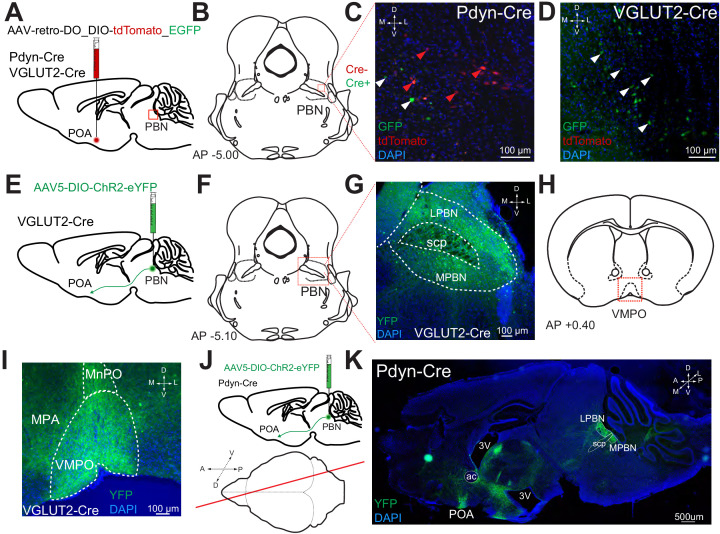
POA-projecting parabrachial nucleus (PBN) neurons are VGLUT2+ and a subpopulation is Pdyn+.(A) Illustration of injections of a retrograde recombinase dependent red-to-green (tdTomato to EGFP) color changing virus (AAV-retro-DO_DIO-tdTomato_EGFP) into the POA of Pdyn-Cre or VGLUT2-Cre mice. (B) Anatomical location of representative brain sections displayed in panels (C) (Pdyn-Cre) and (D) (VGLUT2-Cre). Sections were analyzed for GFP and/or tdTomato expression in LPBN. Cre- neurons transduced by the virus express tdTomato (red), Cre+ neurons express EGFP. (C) In brain sections taken from Pdyn-Cre mice, neurons expressing tdTomato (Cre-, red) and EGFP (Cre+, green) are observed. White arrowheads mark EGFP expressing Cre+ cells; red arrowheads mark tdTomato expressing Cre- cells (n = 3 animals). (D) In brain sections taken from VGLUT2-Cre mice, only Cre+ cells expressing EGFP are observed (white arrowheads). (E) Illustration of viral injections into PBN of VGLUT2-Cre mice to label VGLUT2PBN→POA projections. (F) Anatomical location of representative brain sections displayed in panel G. (G) Expression of eYFP in medial and lateral PBN of VGLUT2+ mice after injection of AAV5-DIO-ChR2eYFP into the PBN. (H) Anatomical location of representative brain sections displayed in panel (I) showing the POA projections of PBN VGLUT2+ neurons. (J) Illustration of injections into the PBN of Pdyn-Cre mice to label anterograde projections and (lower) showing the plane of the sagittal section containing the PBN and the POA in (K) highlighting the dense projections of Pdyn+ PBN neurons to the POA and other brain areas (n = 4 animals).